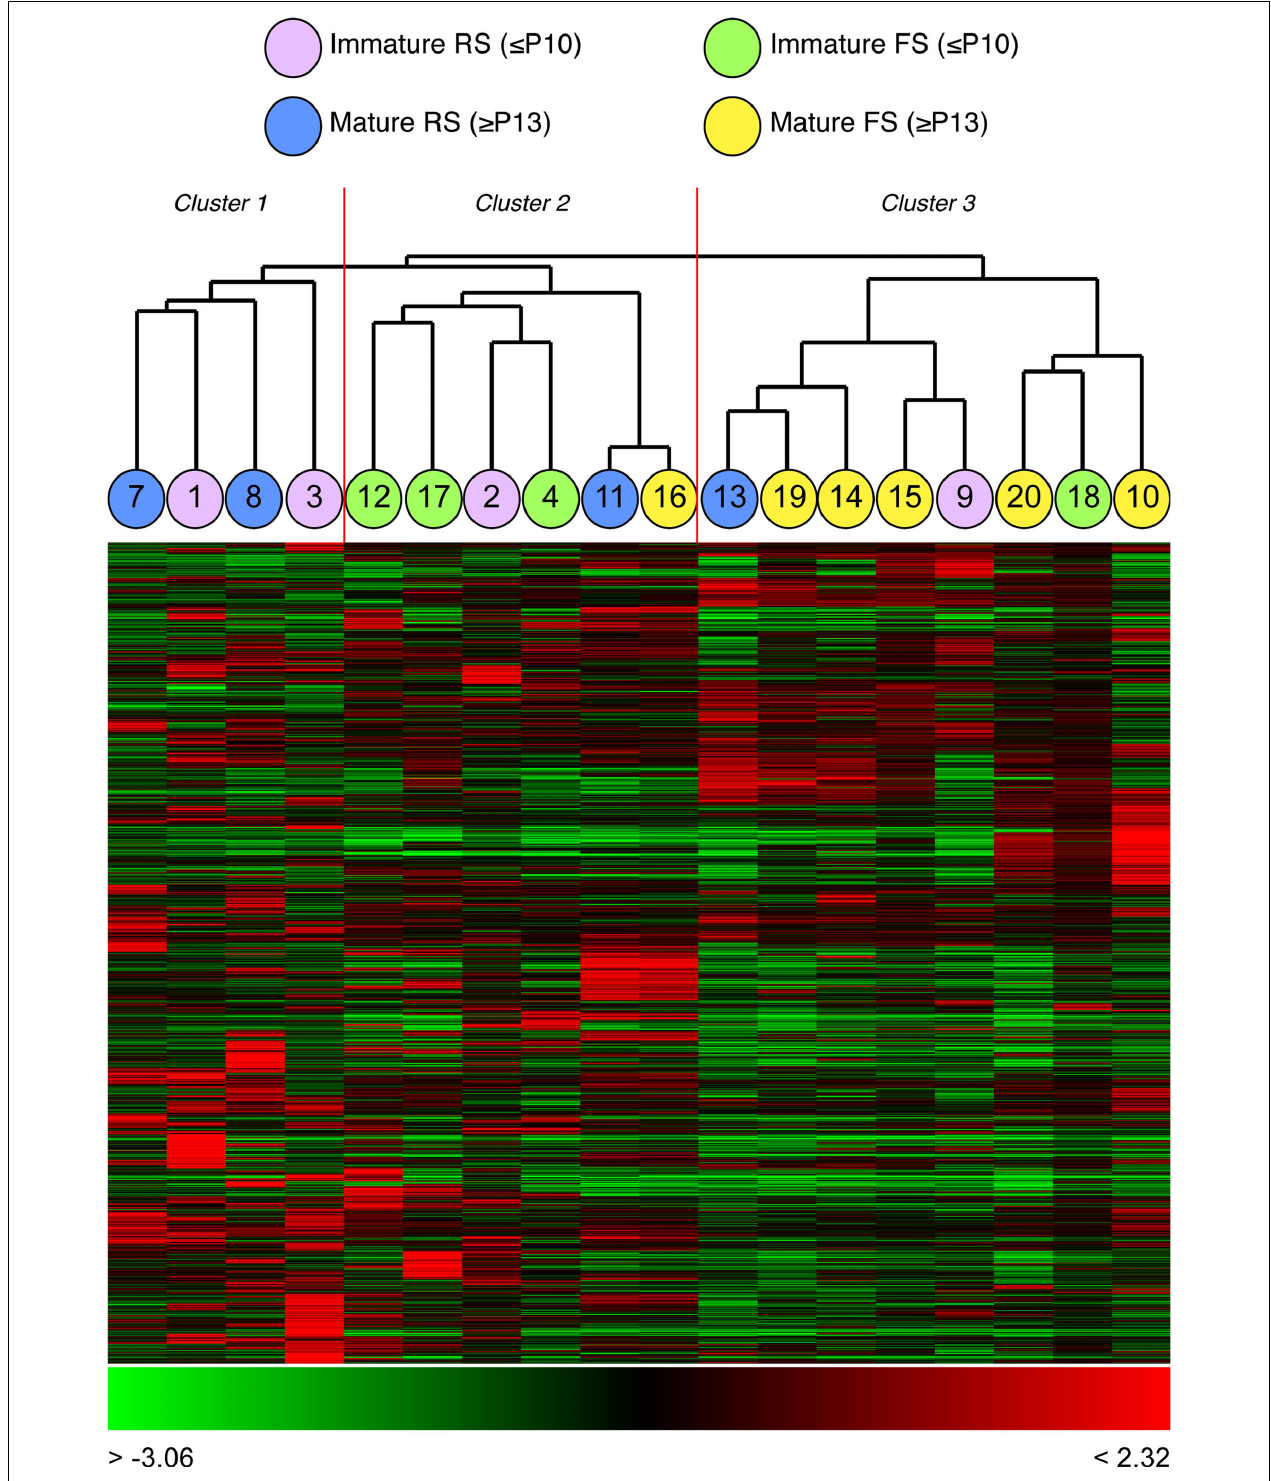
FIGURE 5 | Clustering of all 18 neurons from four postnatal ages, based solely on global gene expression. Three major clusters can be observed: cluster one contains 4 RS neurons of different developmental stages; cluster two contains 6 neurons, 4 of which are FS and 2 are RS; cluster three contains 8 neurons, 6 of which are FS and 2 RS. Cell numbers correspond